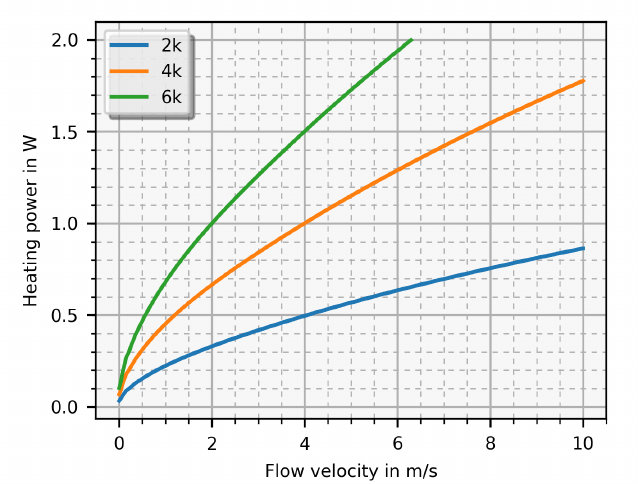
Figure 4. Simulated heating power versus the the flow velocity for three preselected temperature differences ( ∆ T ) with air as test fluid.